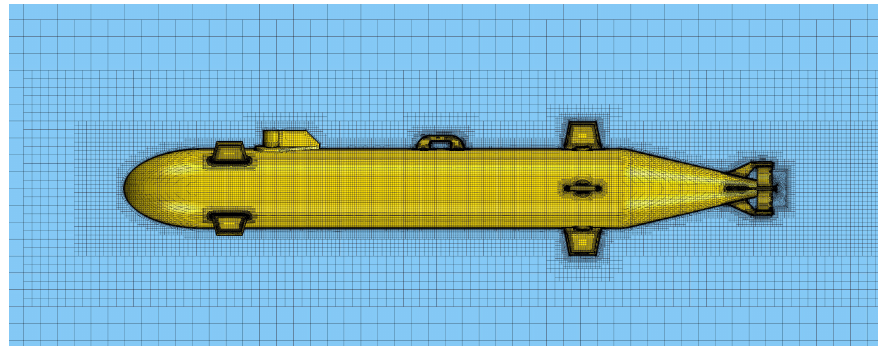
Figure 4. Mesh configuration of AUV.